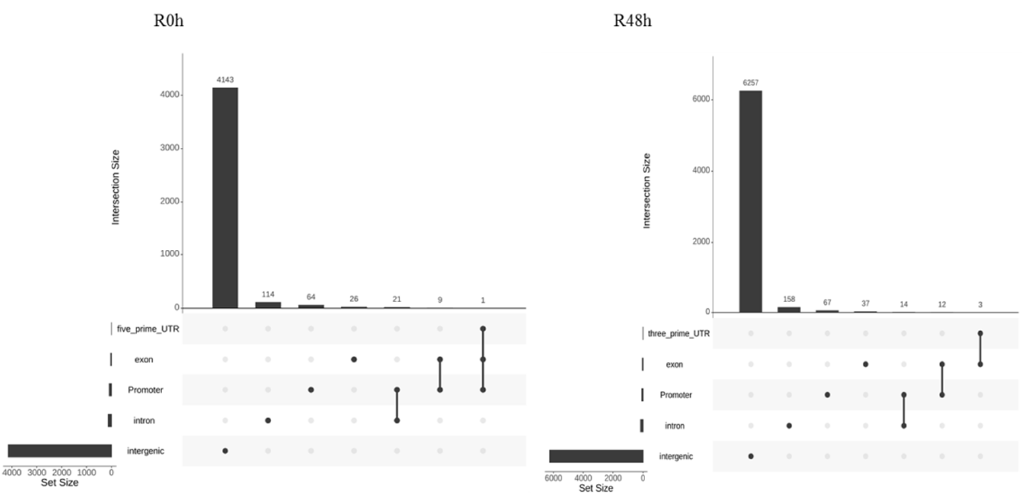
Figure 6. An overview of the genomic distribution of SmTCP7a binding sites for R0 h and R48 h.